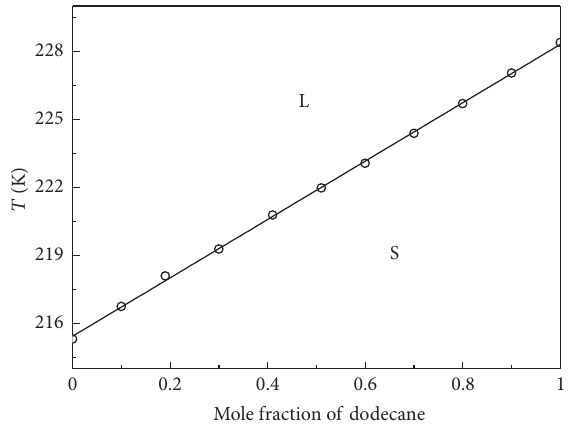
F 7: Experimental phase diagram of C -C in SBA-15